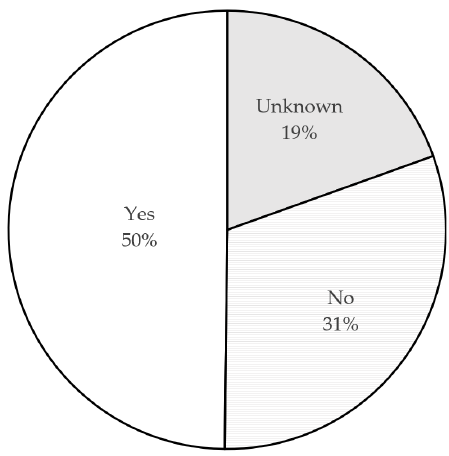
Figure 7. Percentage of respondents who store expired drugs in their homes.